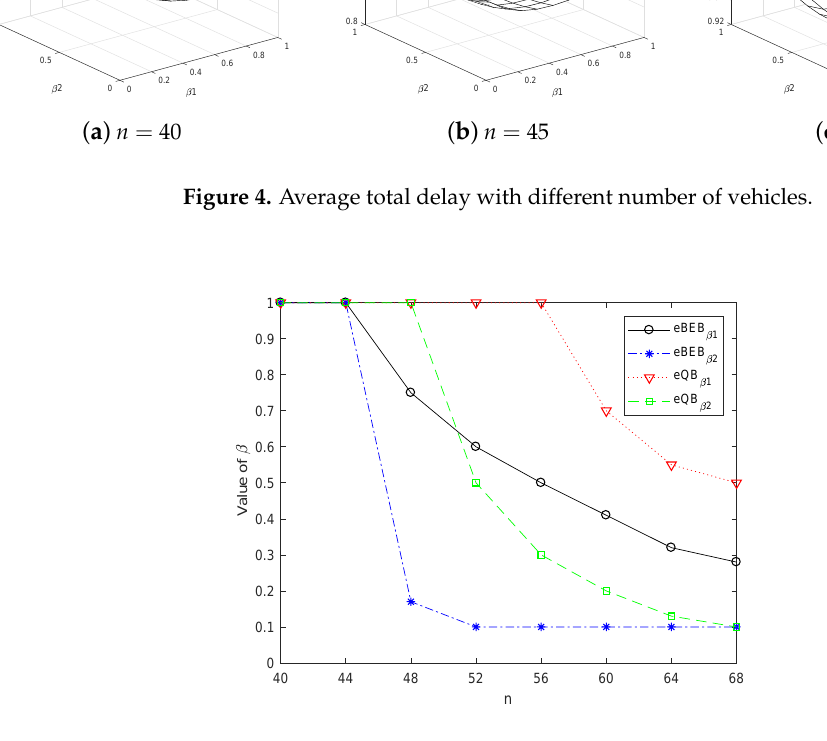
Figure 5. Optimal value of β k of PSO optimization